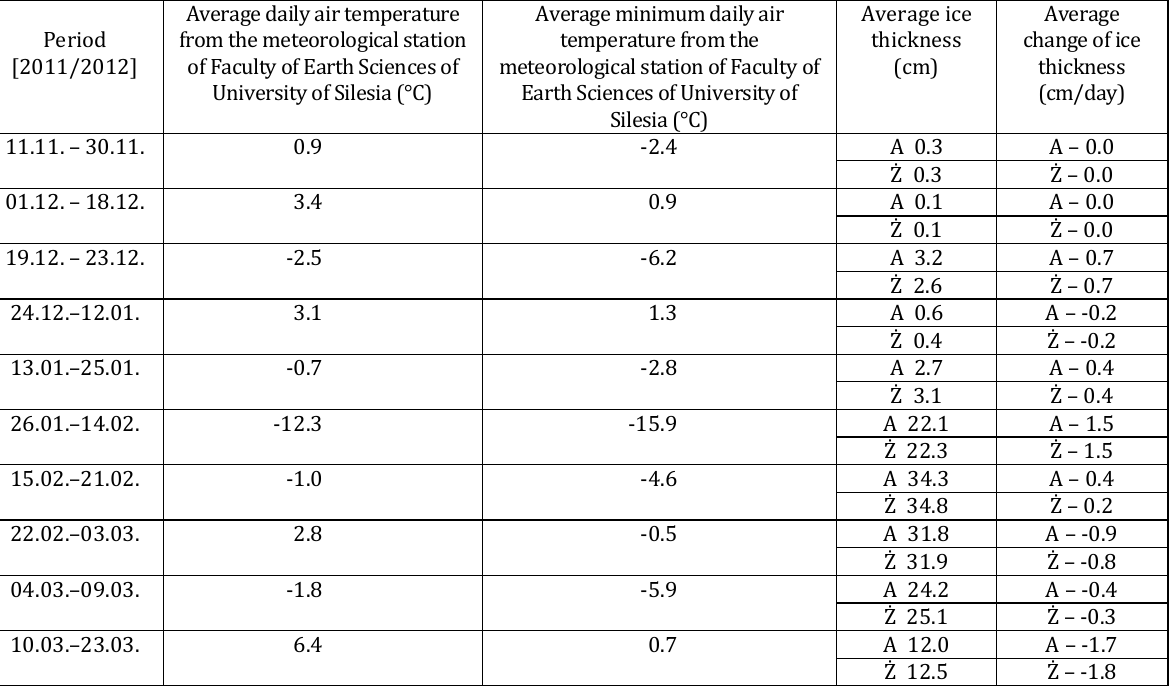
Table 3. Dynamic ice thickness changes in the water